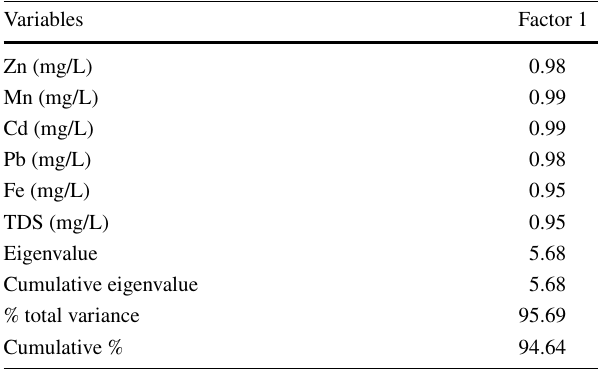
Table 9 Varimax-rotated component loadings in